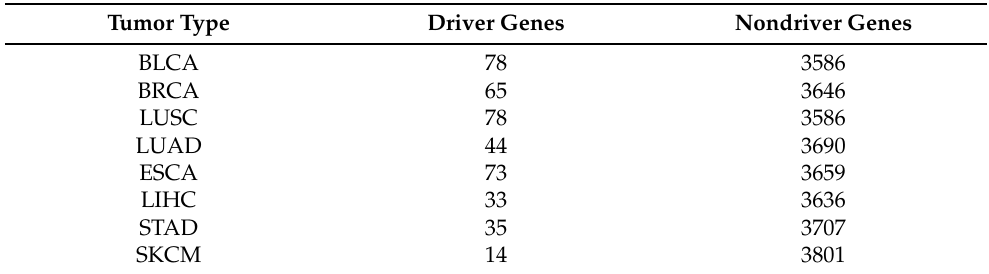
Table 2. Number of driver genes (positive labels) and nondriver genes (negative